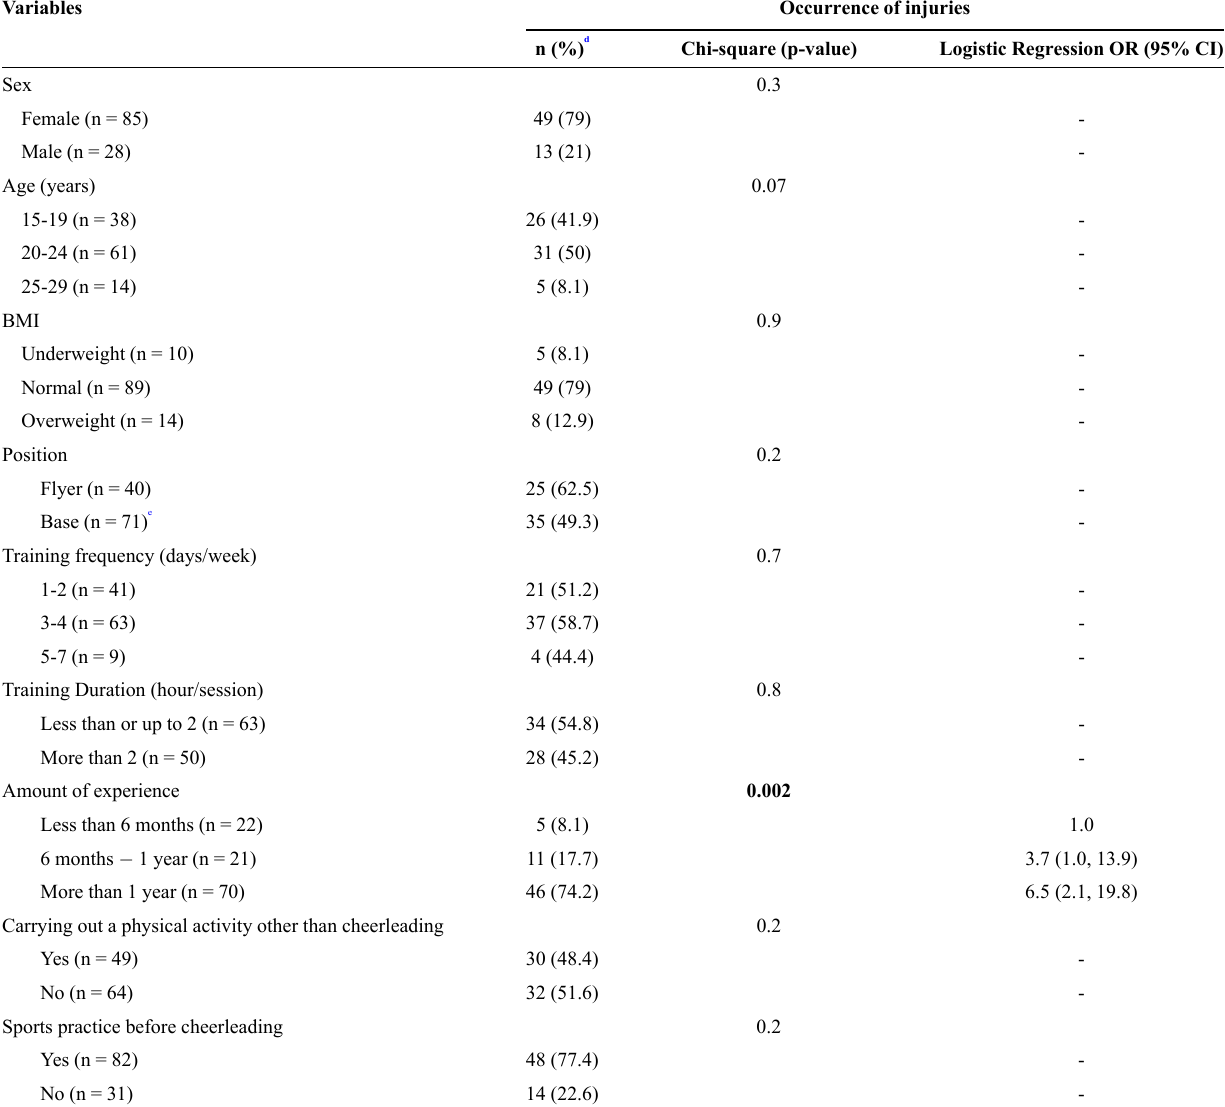
Table 3 - Occurrence of injuries according to descriptive and cheerleading characteristics